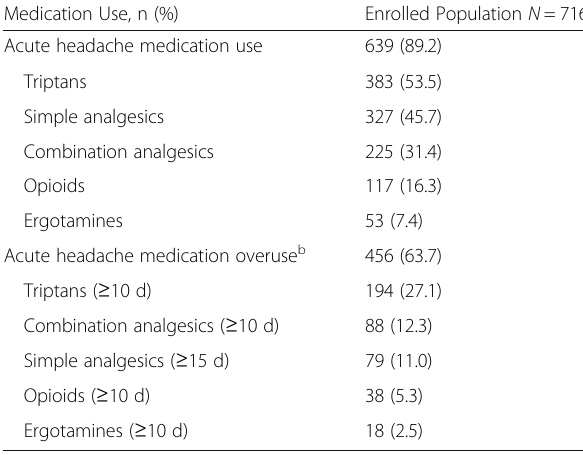
Table 2 Baseline Acute Headache Medication Use in